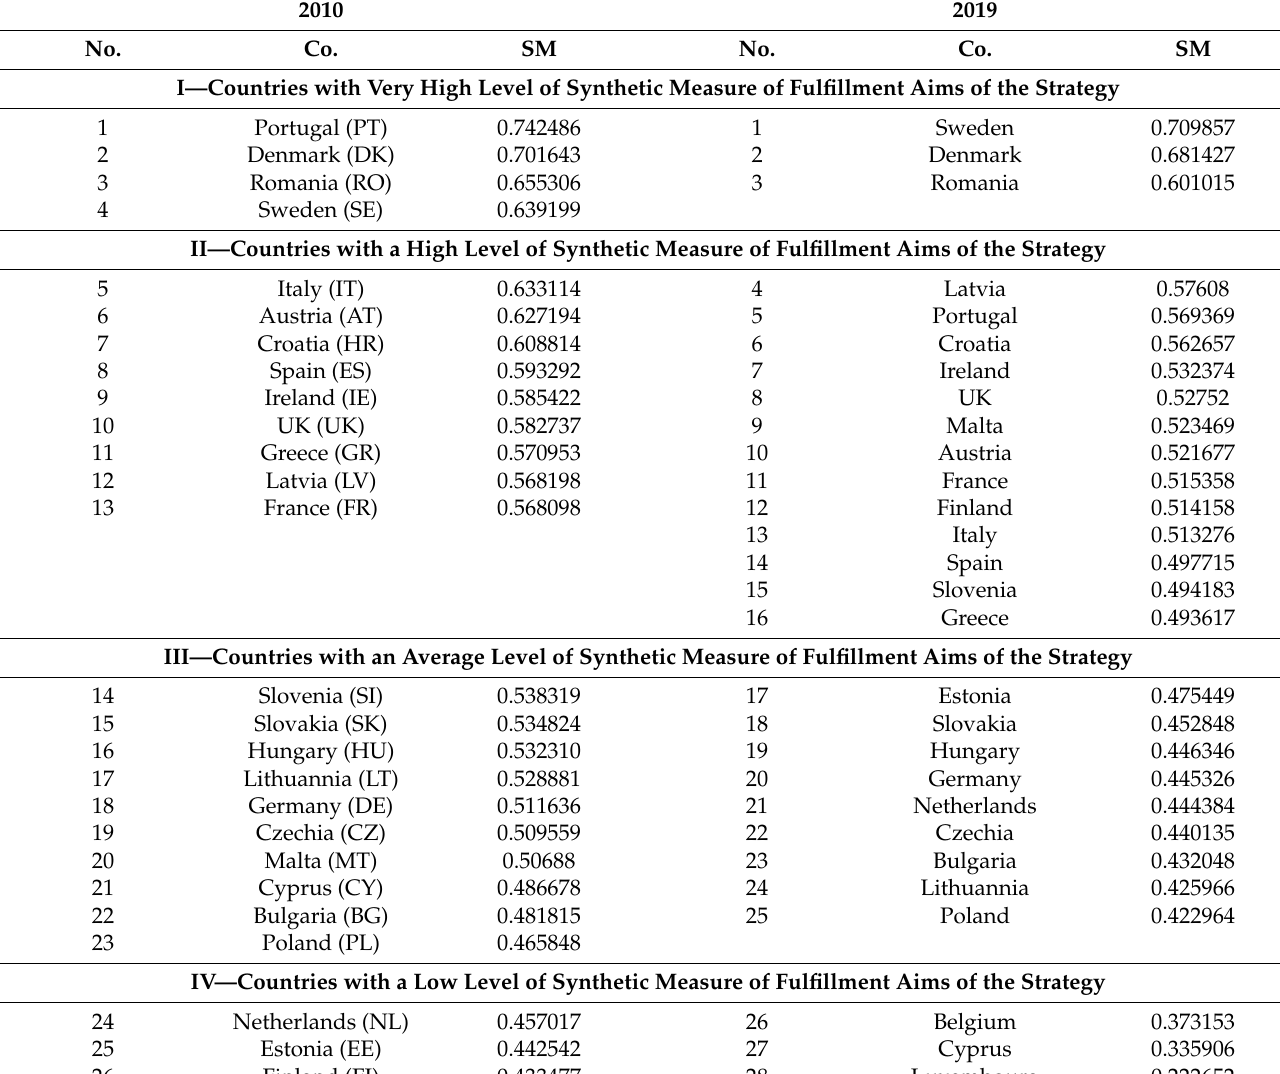
Table 2. The result of multivariate analysis of the set fulfilment of the assumed package of climate/energy targets